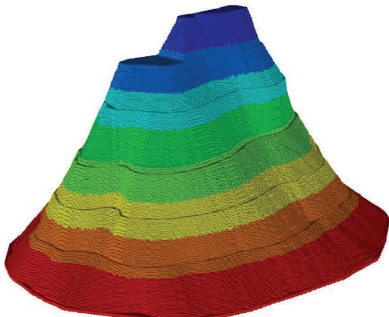
Figure 11: Yee grid model of the mountain.